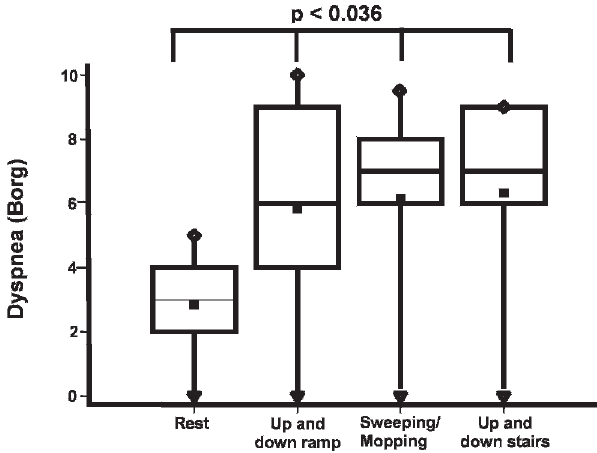
Figure 5 - Boxplot of resting and post-activity (walking up and down a ramp, sweeping/mopping and walking up and down stairs) arterial oxyhemoglobin saturations in COPD patients. Data are presented as medians ¡ maximum/minimum